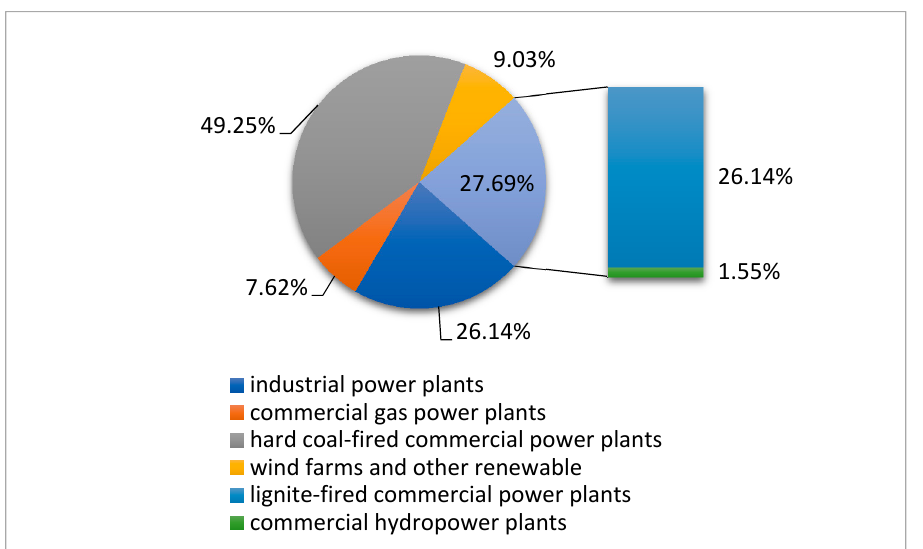
Figure 11. Percentage share in the national electricity production of individual groups of power plants by fuel type in 2019 [48].